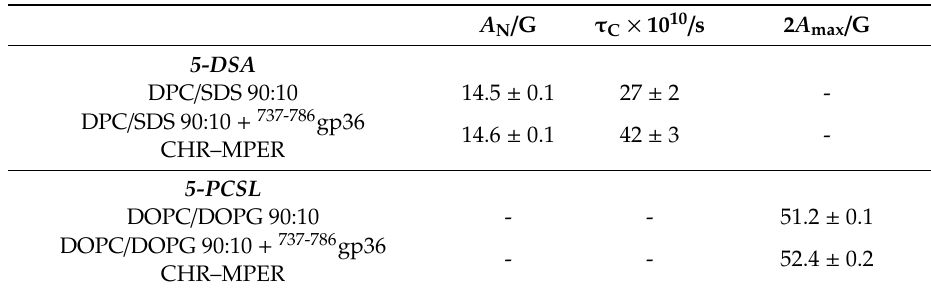
Table 2. Nitrogen coupling constant, A N , spin-label correlation time, τ C , for 5-DSA in micelles and outer hyperfine splitting, 2 A max , for 5-PCSL measured by ESR experiments in the absence and presence of 737-786 gp36